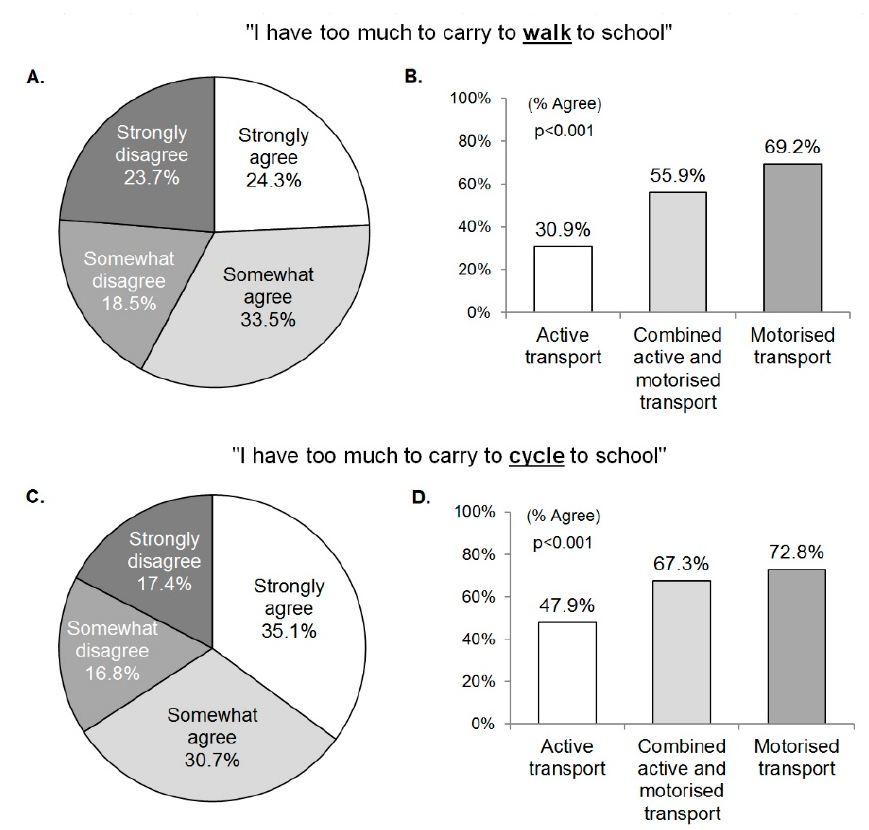
Figure 2. Adolescents’ agreement with the statement that they have too much to carry to ( A , B ) walk or ( C , D ) cycle to school ( A , C ) in a total sample and ( B , D ) by mode of transport to school.